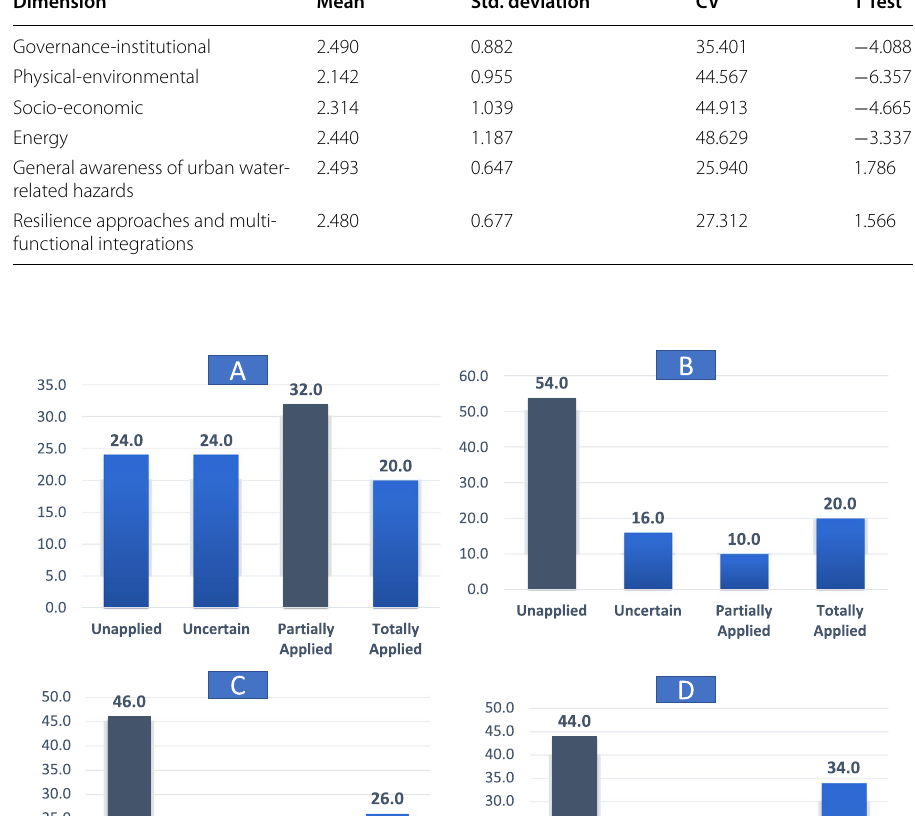
Table 6 Descriptive analysis summarized results Dimension